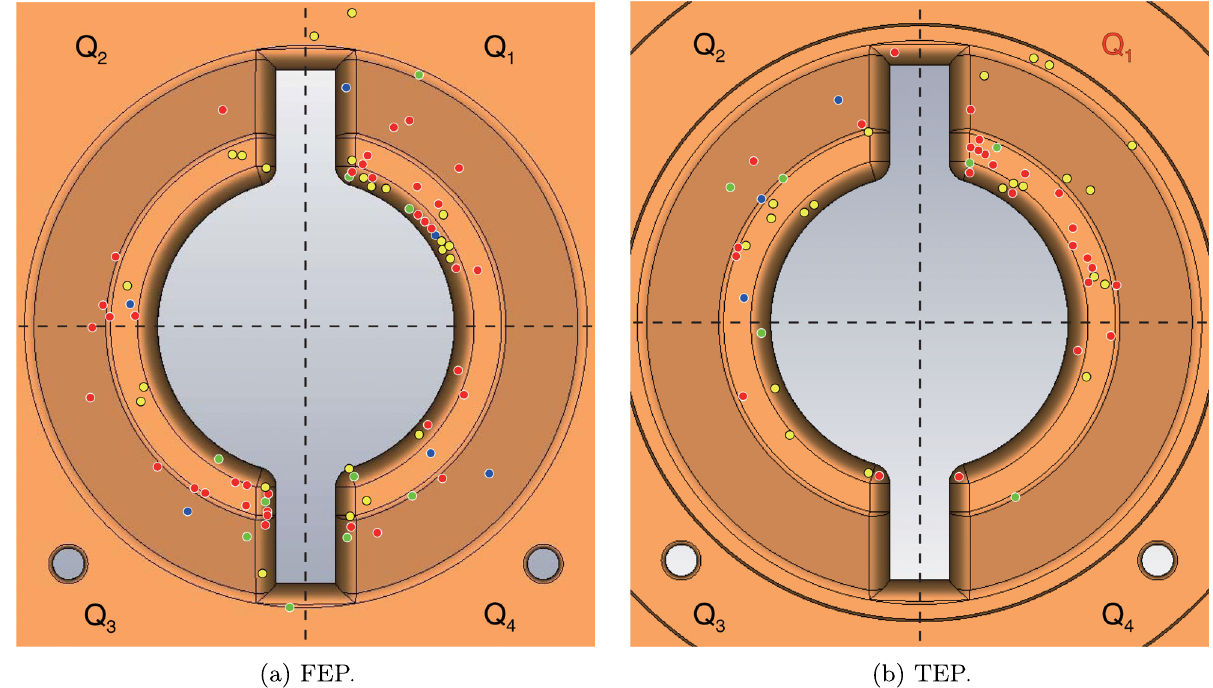
FIG. 17. Distribution of explosion spots for spot-type explosion events, shown as circles. The plot colors of blue, green, yellow, and red indicate cavity voltage ranges of V c ≤ 0 . 40 MV, 0 . 40 MV < V c ≤ 0 . 60 MV, 0 . 60 MV < V c ≤ 0 . 80 MV, and 0 . 80 MV < V ≤ 0 . 95 MV, respectively, at the moment of cavity breakdown. The small holes, two each for the FEP and TEP, c are monitor ports for pickup antennas. The horizontal and vertical dashed lines define the quadrants used in Fig. 18. This partitioning yields the smallest possible sections having the same geometry. Quadrant Q 1 of the TEP, shown in red, is where the brazing filler metal leaked (Appendix B), and the effect of the leakage was at a visual